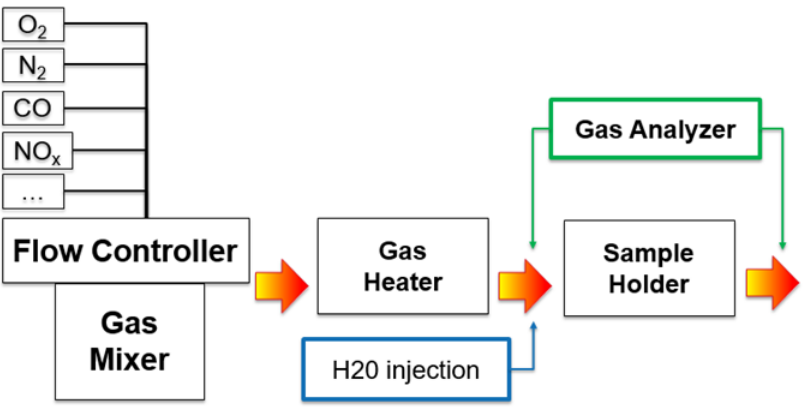
Figure 8. Schematic layout of the Synthetic Gas Bench (SGB) used for the catalyst testing.